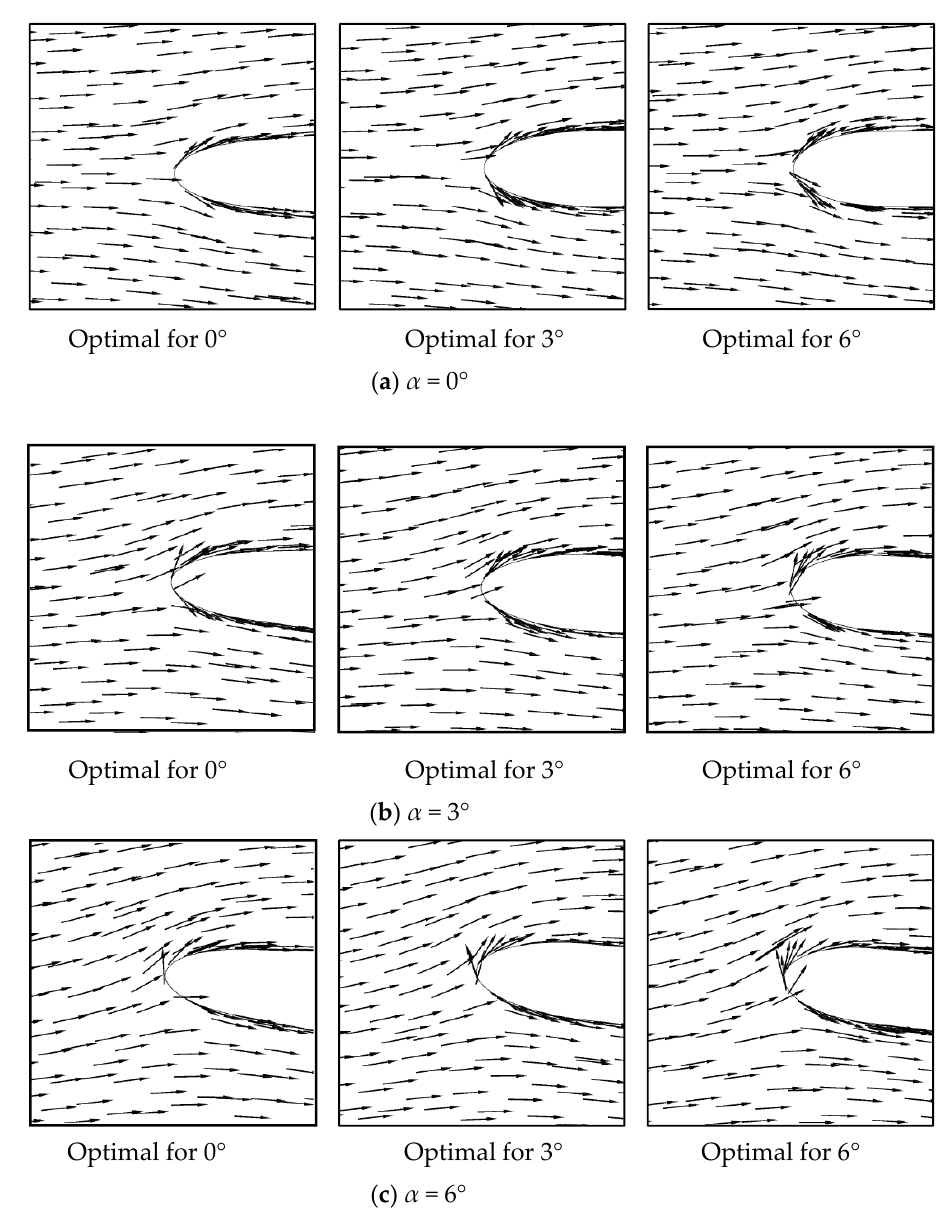
Figure 10. Velocity vectors around the foils .